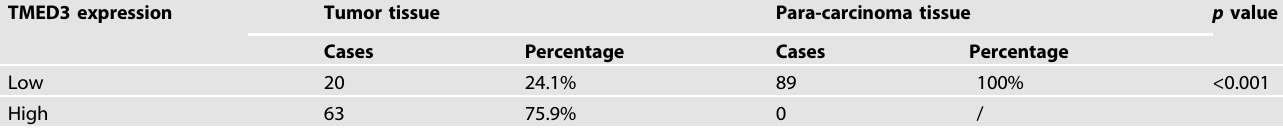
Table 1. Expression patterns in lung squamous cell carcinoma tissues and para-carcinoma tissues revealed in immunohistochemistry